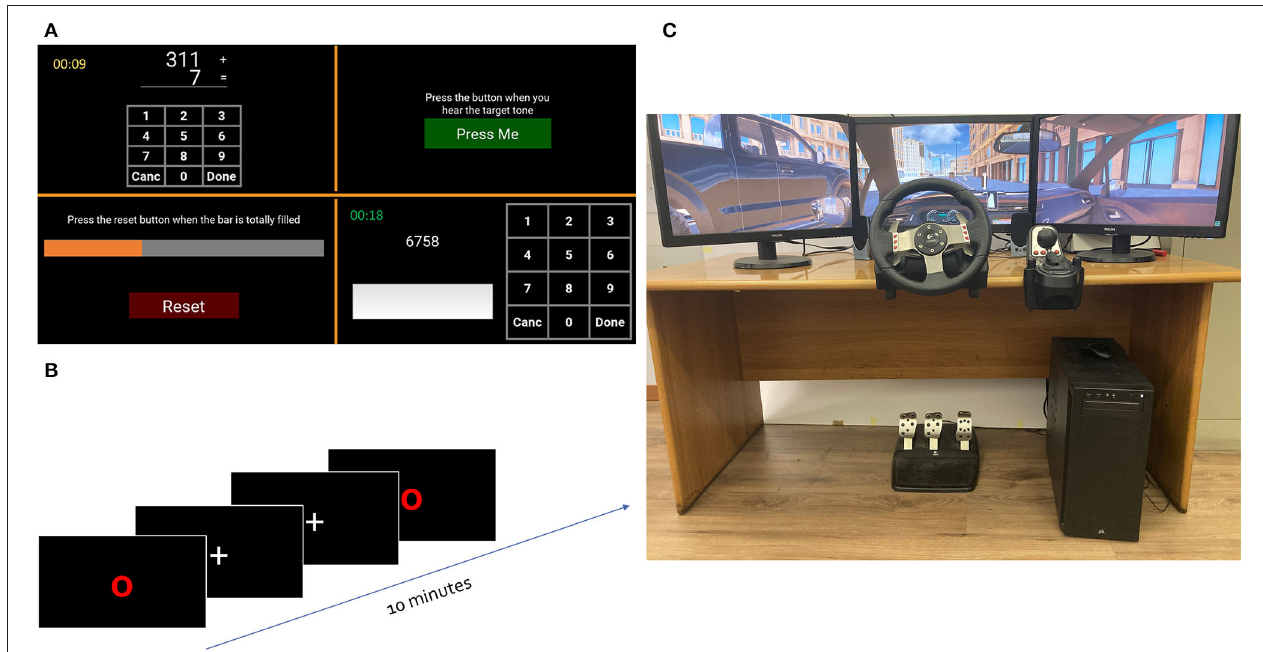
FIGURE 2 | Experimental settings. (A) Multitasking application screen. In clockwise order, they are the auditory monitoring, the phone number entry task, the visual monitoring, and the mental arithmetic task. (B) Psychomotor vigilance task (PVT). During a 10-min stimulation, the subjects are required to press the space bar on the keyboard only when the red circle appears. (C) Car simulator. Car Driving simulator where the experimental participant is sitting.